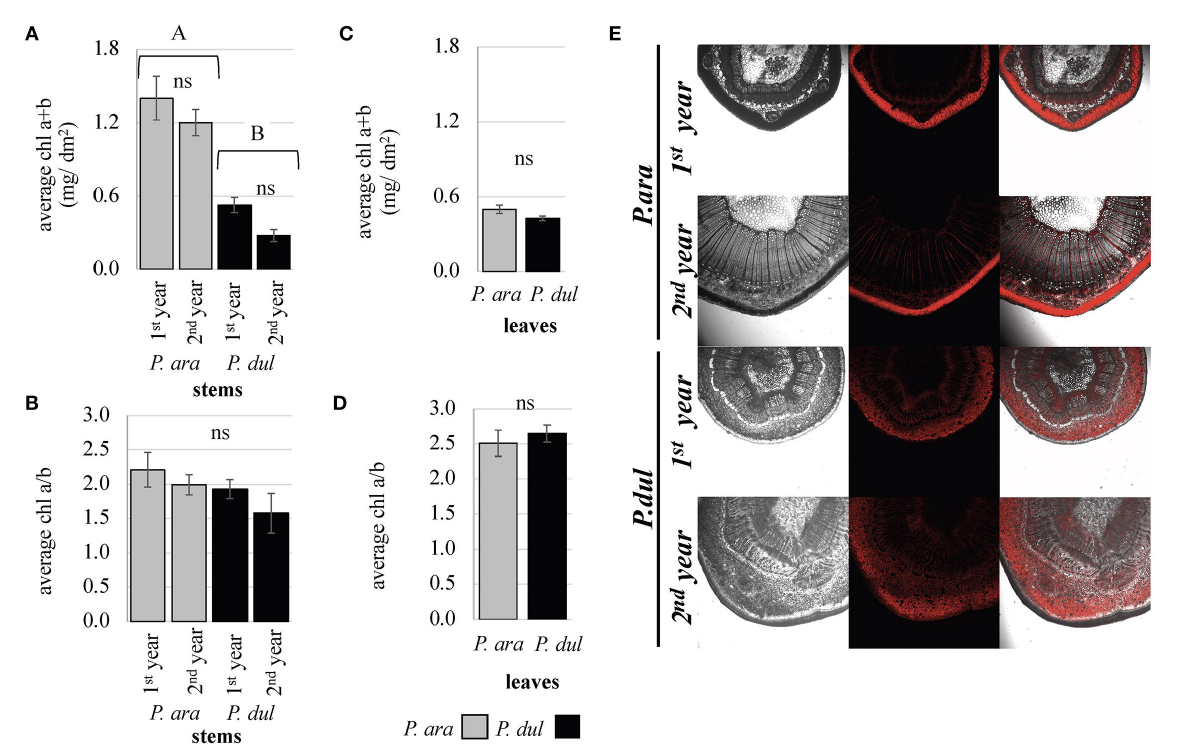
FIGURE3 Chlorophyll levels and distribution in P. arabica stems and leaves compared to P. dulcis. Chlorophyll a and b levels of P. arabica and P. dulcis 1 st and 2 nd -year stems (A) and fully developed leaves (C) . The chlorophyll a/b ratio of P. arabica and P. dulcis 1 st and 2 nd -year stems (B) and fully developed leaves (D) . Data are the means ± SE of 4 samples of leaves/stems from each species. Each sample consisted of 1 leaf or stem, except for the P. arabica leaf sample, which consisted of 4 leaves. Statistical analysis of the data was carried out using one-way ANOVA (leaves) and two-way ANOVA (stems). Different letters above the bars indicate significant differences (Student’s T- test, p < 0.05). ns, non-significant. No interaction between almond species and stem age was found in 2-way ANOVA. (E) Confocal microscopy reveals a distinguished chlorophyll (red-autofluorescence) distribution in P. arabica stems, which is concentrated under the epidermis in the parenchyma layer, while, in P. dulcis , the chlorophyll was distributed among different stem layers.